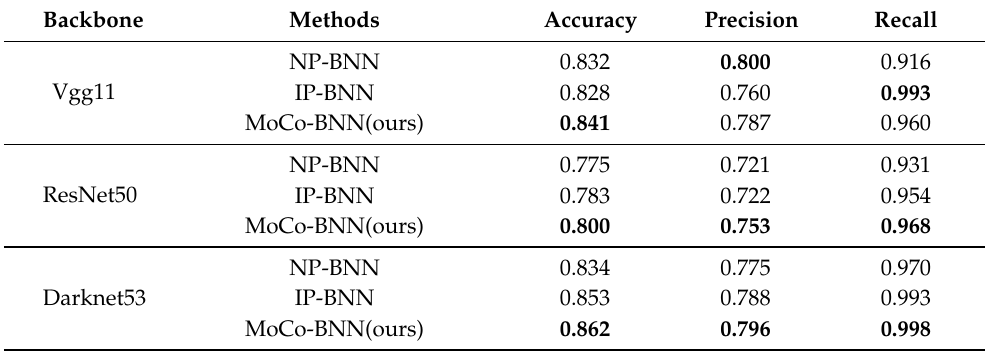
Table 3. Results for BNN patch-matching on SEN1-2 with different pre-training methods.